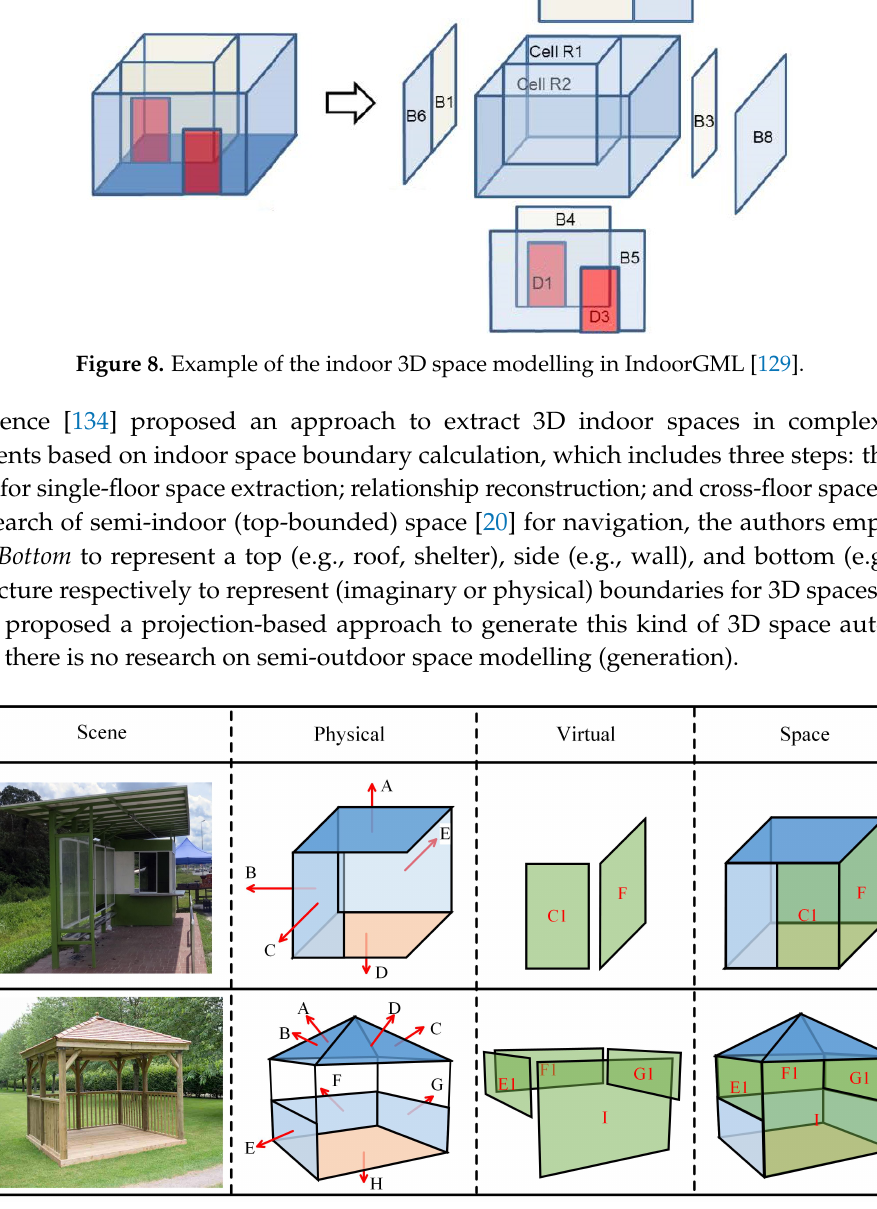
Figure 9. Example of the semi-indoor (top-bounded) space modelling based on 3D geometric representations